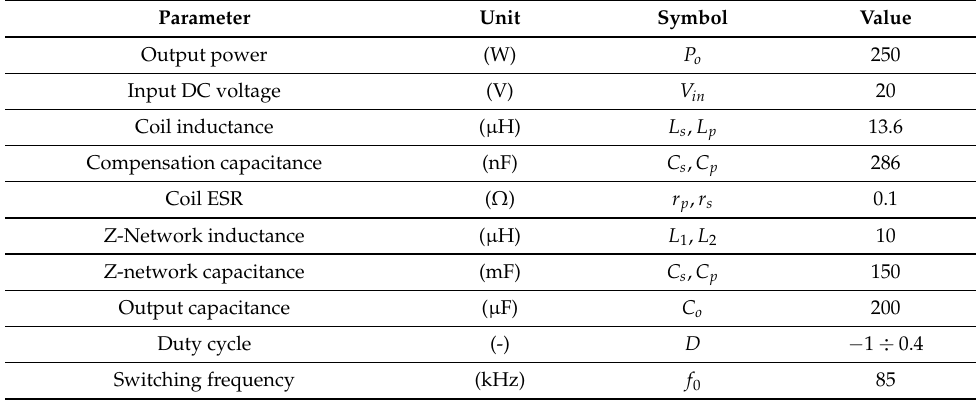
Table 3. Laboratory Prototype Parameters.